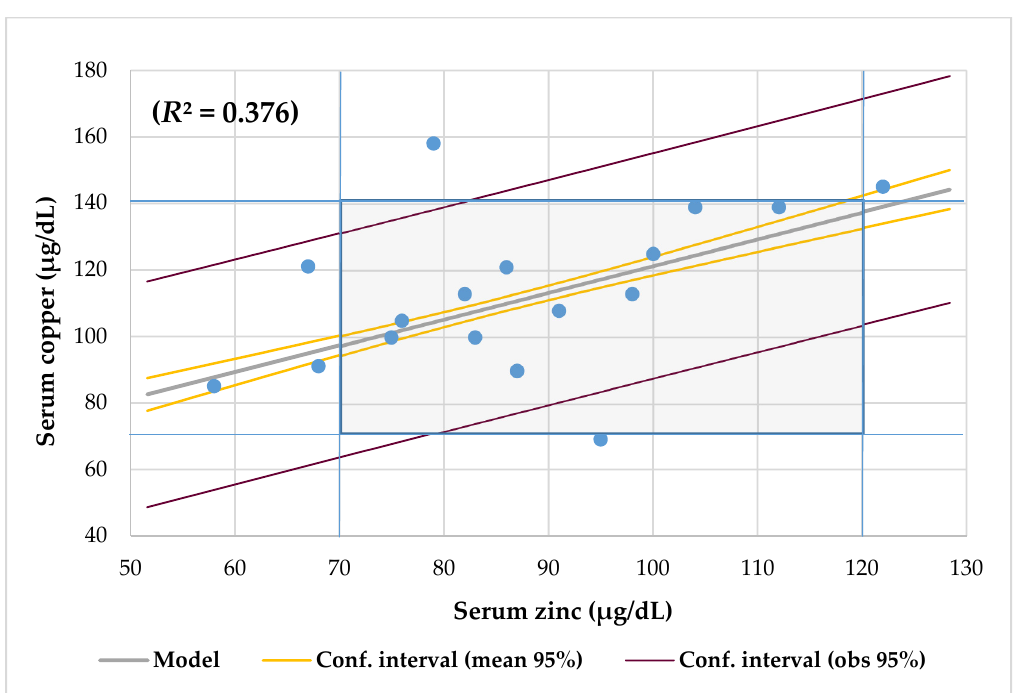
Figure 3. Regression serum copper (70–140 μ g/dL) by zinc (70–120 μ g/dL) adjusted for age and cut-offs.